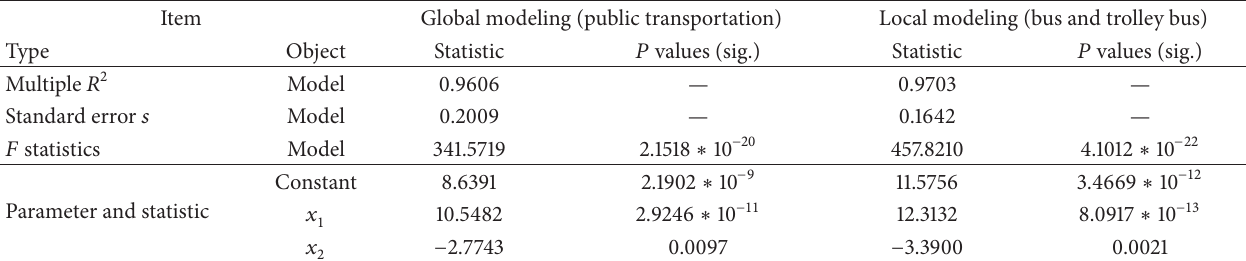
Table 3: Main statistics based on the multiple linear regressions for two types of models on the public transportation of China’s cities (2012).